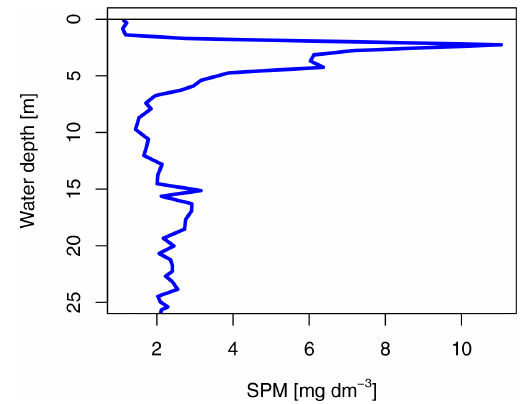
Figure 3. Turbidity profile of the SG station converted to suspended